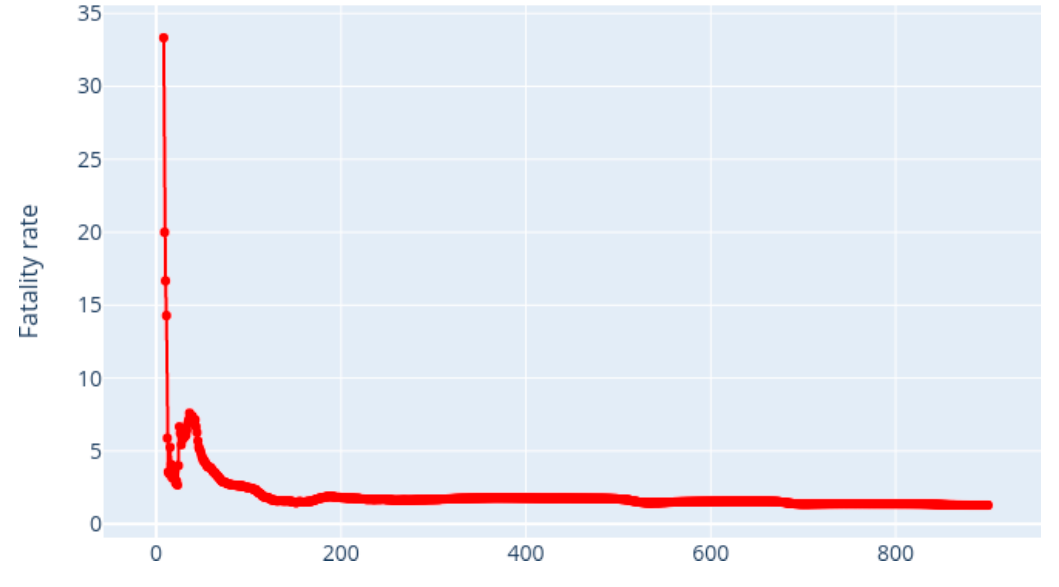
Figure 10. Morocco: The fatality rate.